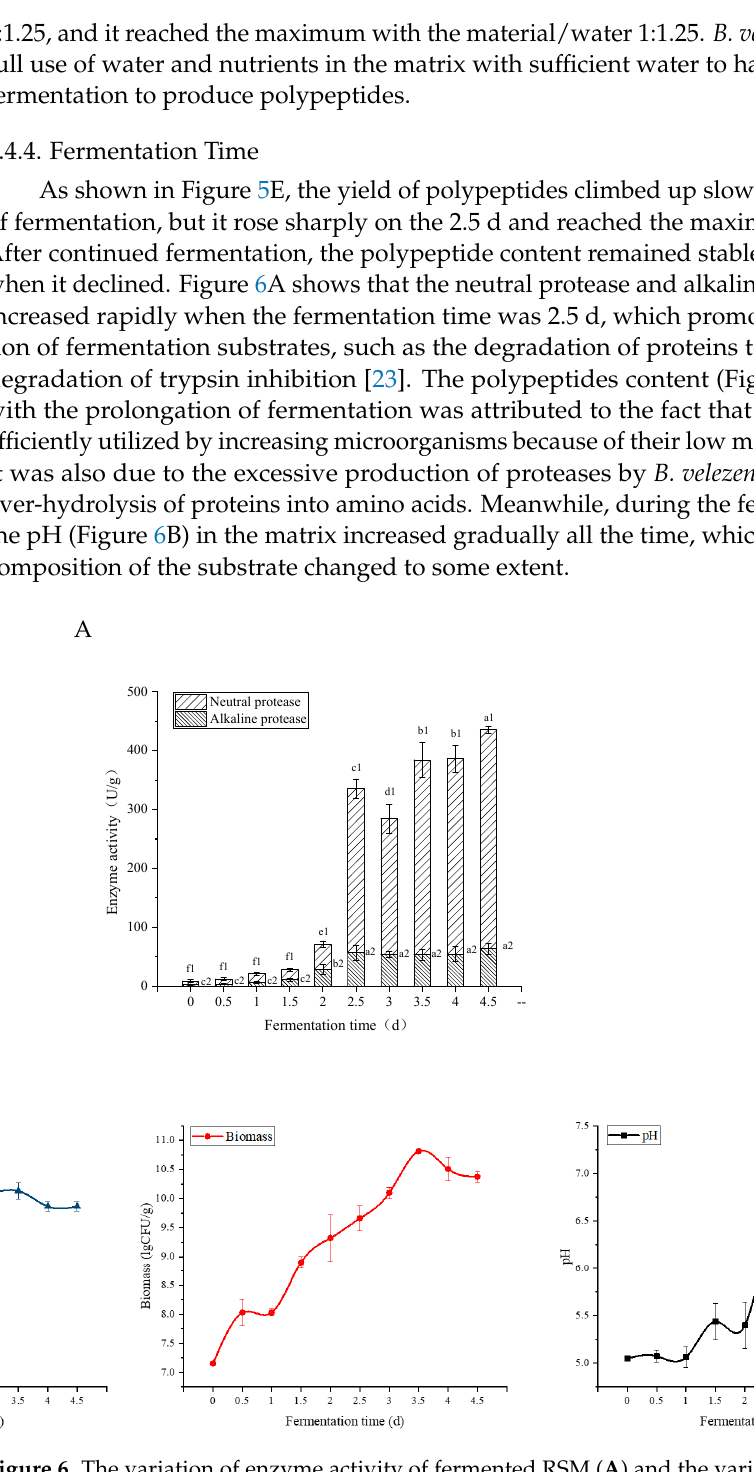
Figure 6. The variation of enzyme activity of fermented RSM ( A ) and the variation of polypeptides, biomass, and pH in fermented RSM ( B ). Bars with different letters differ significantly ( p <